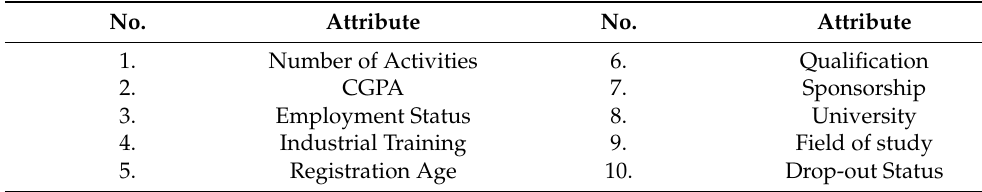
Table 5. Model B (MinMaxScaler and supervised feature